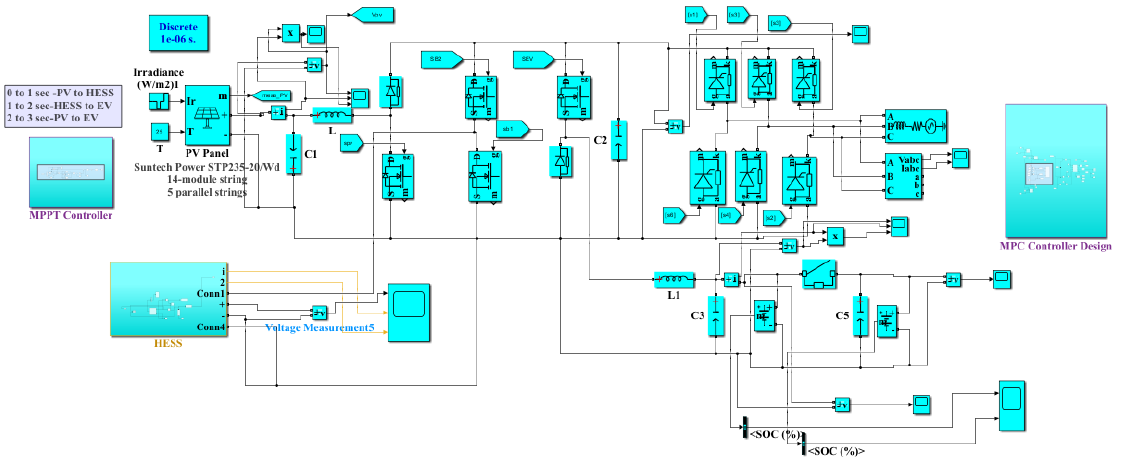
Figure 18. Simulink diagram of the proposed MPC model.